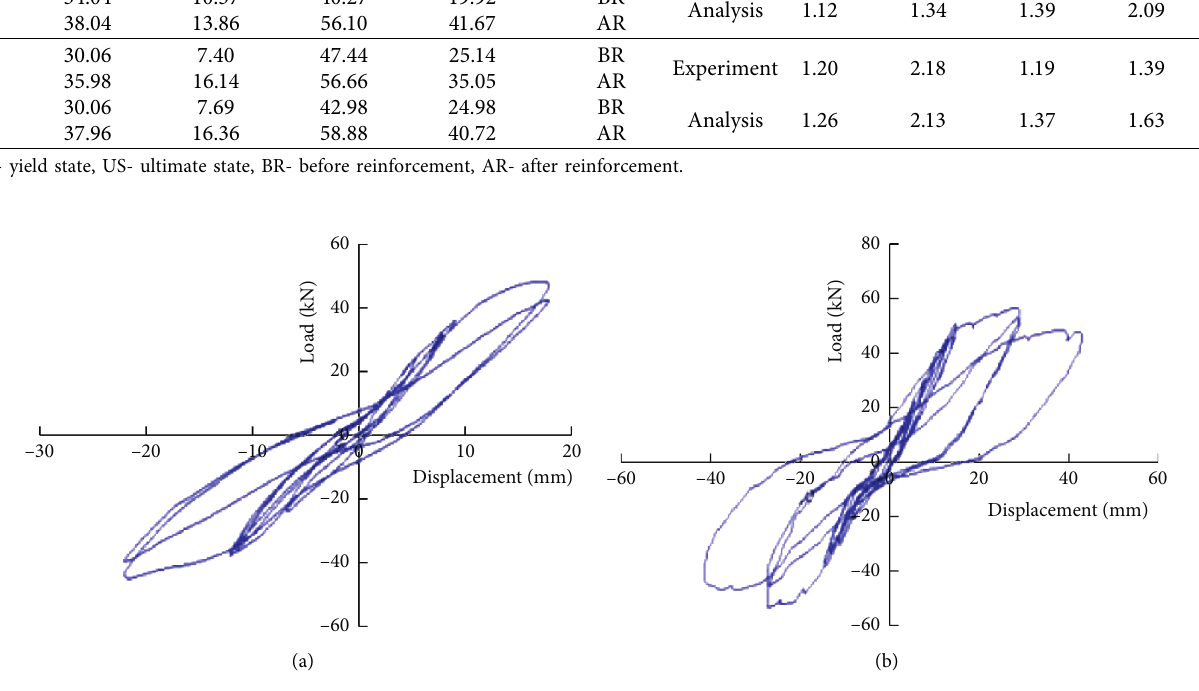
Figure 4: Comparison of the hysteretic curves of model 1 (experimental results): (a) before reinforcement; (b) after reinforcement.